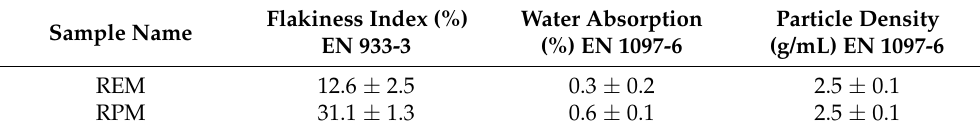
Table 1. Physical properties of REM and RPM given as the arithmetic mean ± 1 standard deviation, n = 3.